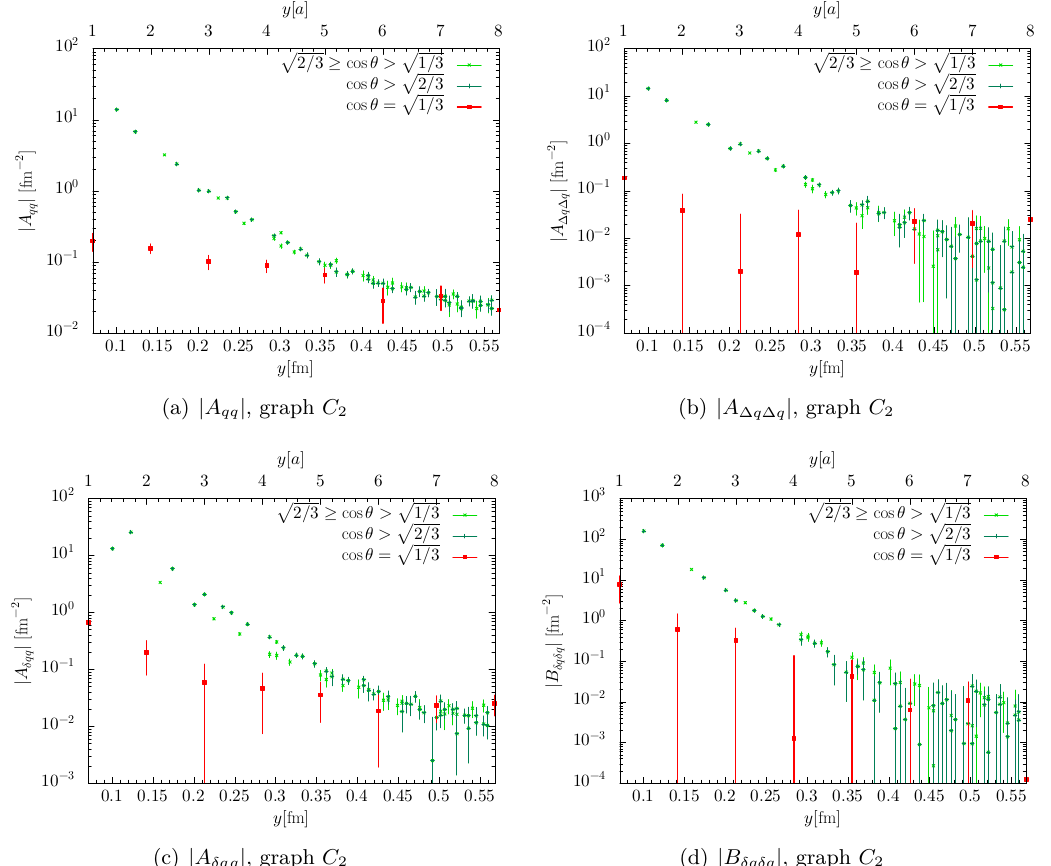
Figure 7 . Twist-two functions at small y for graph C 2 . All points are for L = 40 , zero pion momentum, and light quarks. For A δqδq (not shown), one finds a clear anisotropy at y < 4 a , whilst at larger y the statistical errors are too large for drawing firm